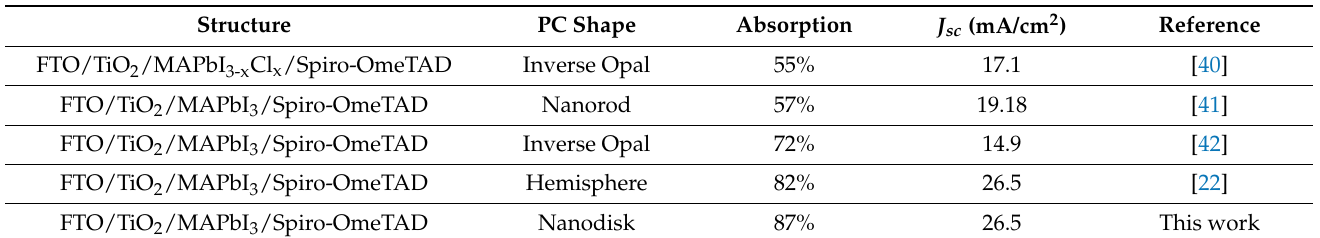
Table 3. The comparison of optical performance in this work with previous studies about applica- tion of PC on PSC at 446 nm of wavelength.